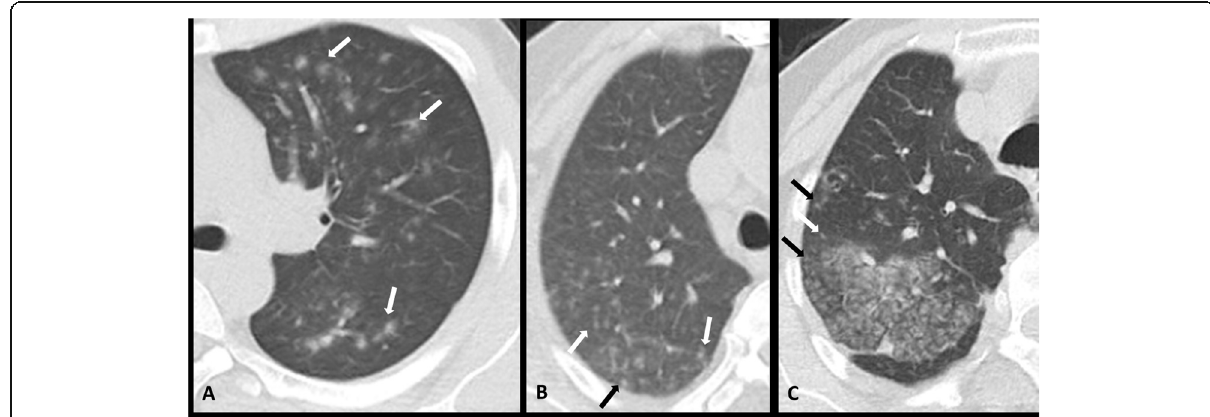
Fig. 3 Nodular opacities: small and round, ill-defined nodules of soft tissue density (some indicated with arrows) in 3 different patients with RT-PCR-confirmed COVID-19